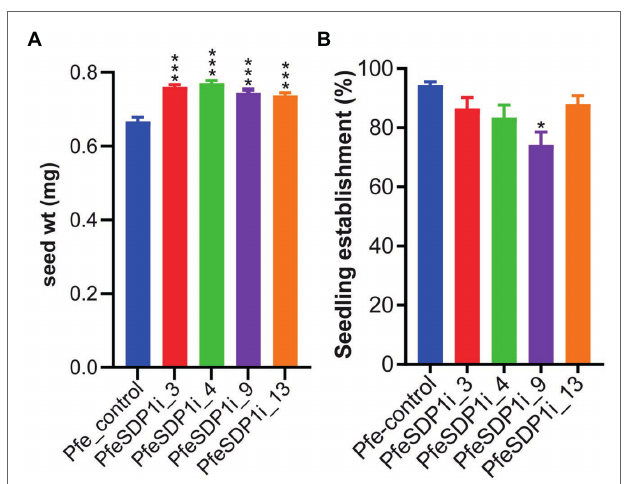
FIGURE 3 | Seed-specific PfeSDP1_RNAi increases seed weight and has a limited effect on seed establishment. (A) The seed weight of PfeSDP1_RNAi T1 generation plant seeds (T2 seeds) represent the average seed weight ( n = 10). (B) Percentage of seedling establishment after 4 days in light (16 h light/8 h dark), defined by the development of the green cotyledonary leaves. Asterisks (*) and (***) indicate significant differences at p ≤ 0.05 and p ≤ 0.0005 to the control by two-tailed paired t